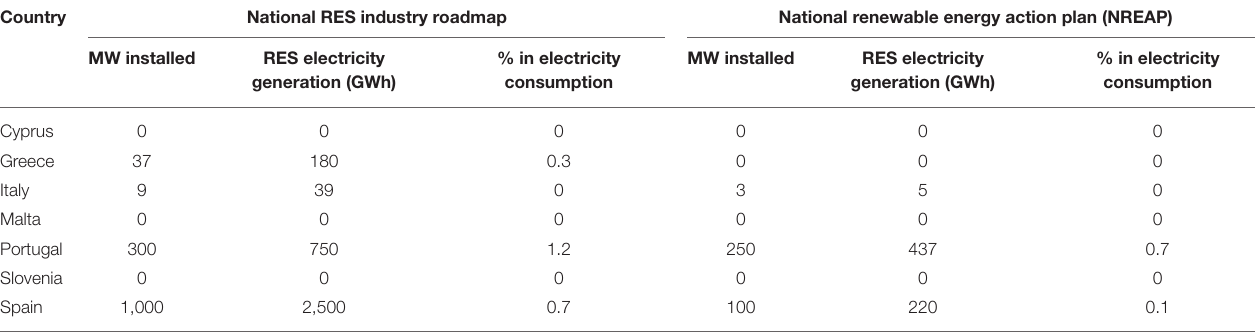
TABLE 2 | Projections for renewable electricity in 2020 from tidal, wave, and ocean energy (Zervos et al., 2011).